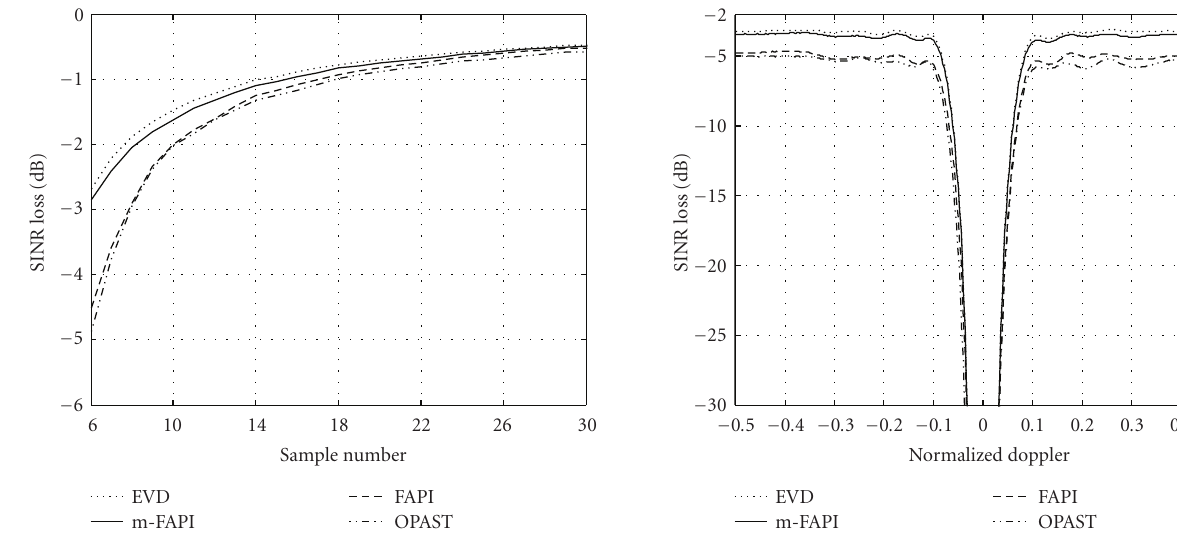
Figure 3: SINR loss versus sample number. Figure 4: SINR loss versus normalized